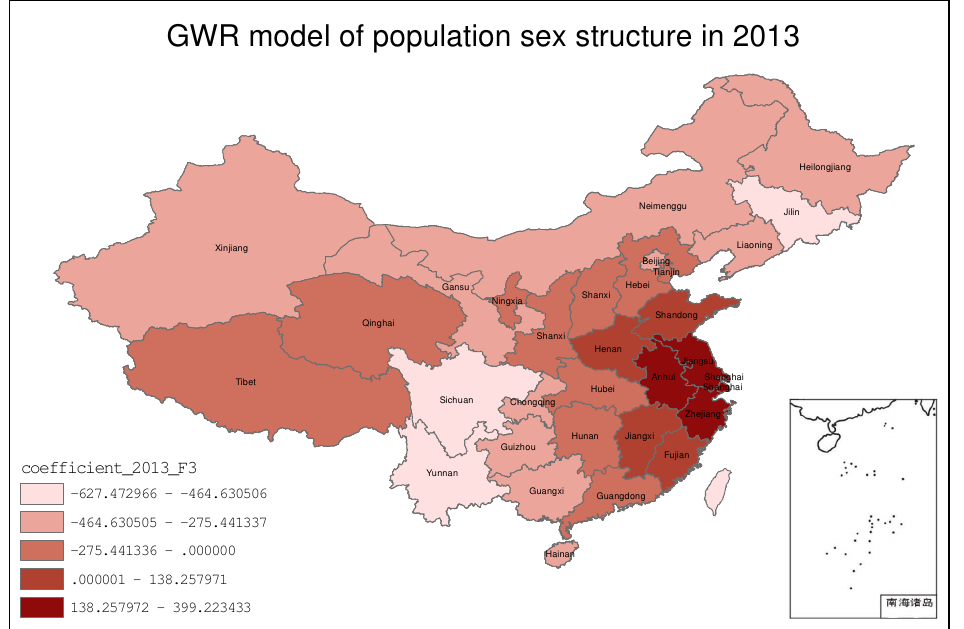
Figure 4. The regional difference map of population sex structure influencing factor in GWR model